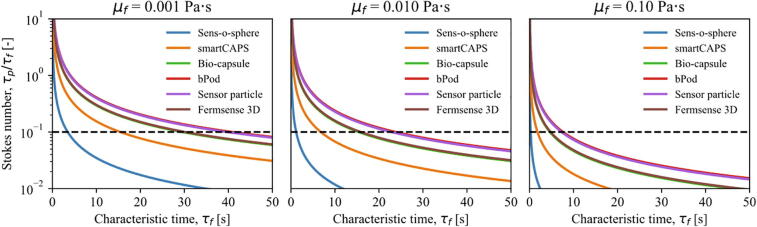
Stokes number as a function of the characteristic time for the reviewed sensor devices. The relationship is presented for water (0.001 Pa s) and for a low (0.01 Pa s) and a high viscosity (0.1 Pa s) fermentation. The figure serves as a comparison of how the diameter of the sensor devices and the fluid viscosity affects the flow following capabilities. The presented values are only rough estimates as the velocity of the sensor devices compared to the fluid is assumed to be constant, at 0.05 m/s. In addition, perfect buoyancy (ρp/ρf) = 1 is assumed.